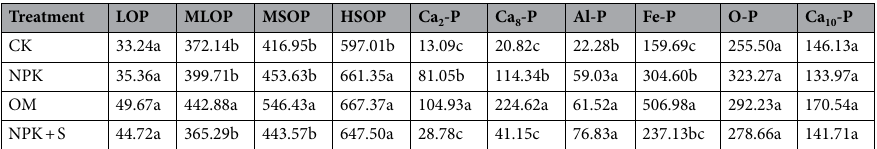
Table 3. The effect of treatments on the accumulation of different P fractions in the 0–20 cm soil depth (kg ha −1 ). Values followed by different letters at the same row differ significantly at P < 0.05. CK, no fertilizer application; NPK, chemical fertilizer application; NPK + S, chemical fertilizer plus maize straw incorporation; OM, organic manure application. LOP, labile organic P; MLOP, moderately labile organic P; MSOP, moderately stable organic P; HSOP, high stable organic P.